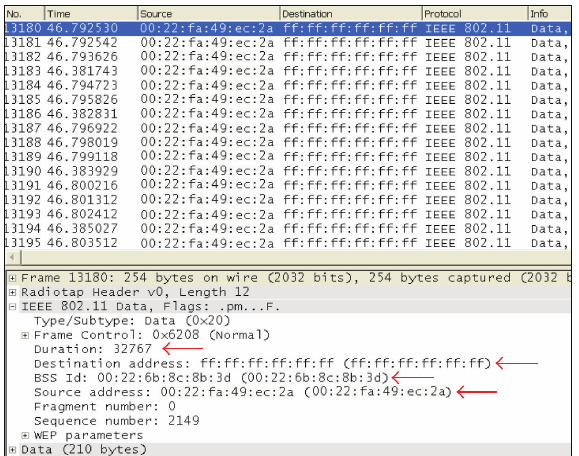
Figure 11: Live capture of the data replay attack.